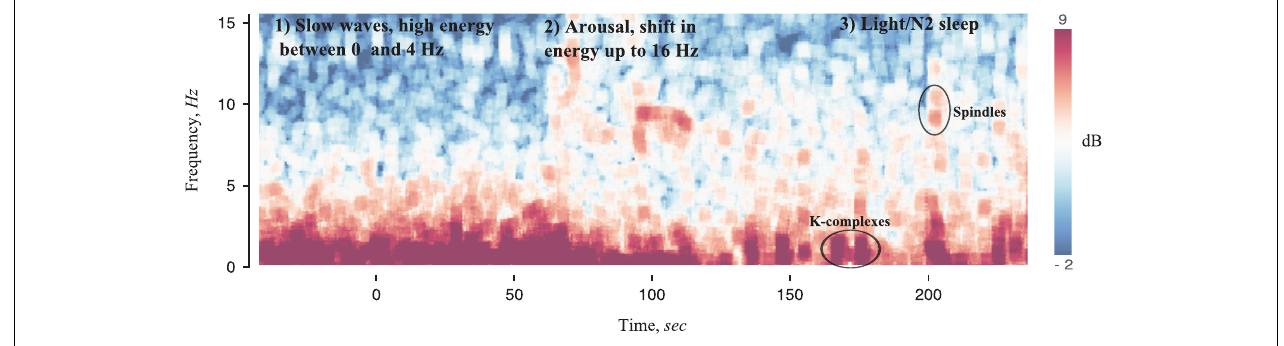
FIGURE 3 | Spectrogram of sleep EEG signals using methods developed in Prerau et al. (2017). A transition from slow wave sleep (1) to N2 sleep (3) with an arousal in the middle (2) is observed. Slow wave sleep is characterized by high absolute power at frequencies less than 4 Hz and very little power at high frequencies, thus making identification of high frequency (8–16 Hz) arousals straight-forward. The transition from arousal to N2 sleep is also very specific, with a reduction in high frequency power, a sparse low frequency burst (likely reflecting K-complexes), sometimes followed by a burst of 12–16 Hz activity.